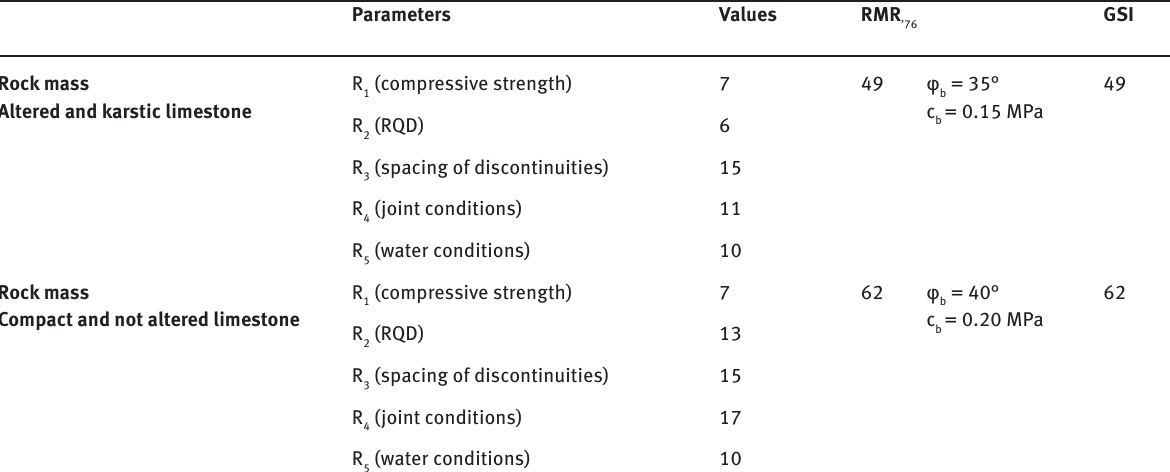
Table 1: Geomechanical classification of the altered and the compact calcareous rock mass. Parameters